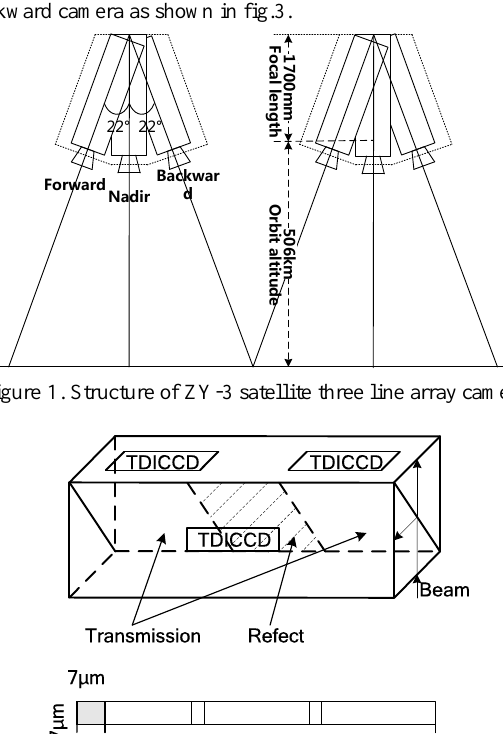
fig.2. And four charge coupled device arrays, each pixel size of